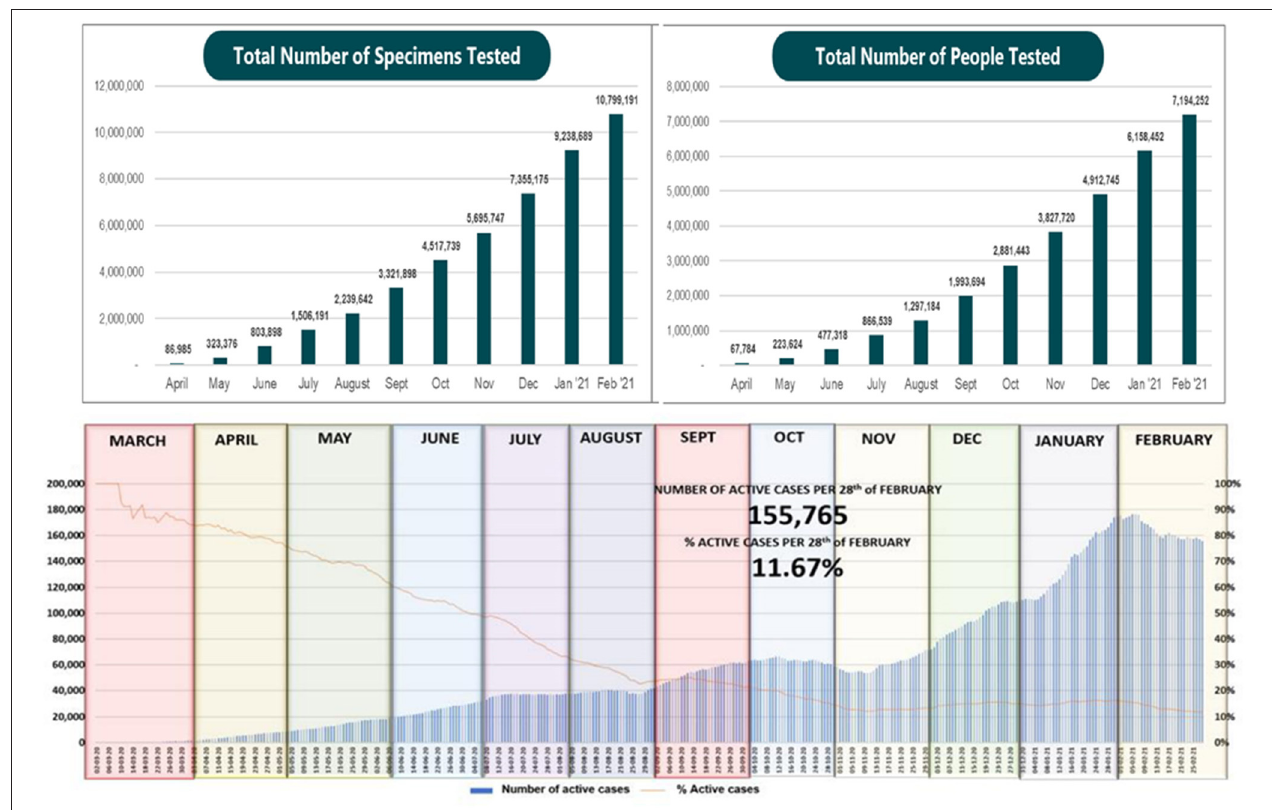
FIGURE 2 | ( A , Upper Left) total number of specimens tested in Indonesia June 2020 - February 2021; ( B , Upper Right) Total number of people tested in Indonesia June 2020-February 2021 (24); (Below) the number of active cases reported in Indonesia per month (March 2020-February 2021). institutions for strong cross-sectoral collaborations to ease logistics distribution pressures during the COVID-19 pandemic